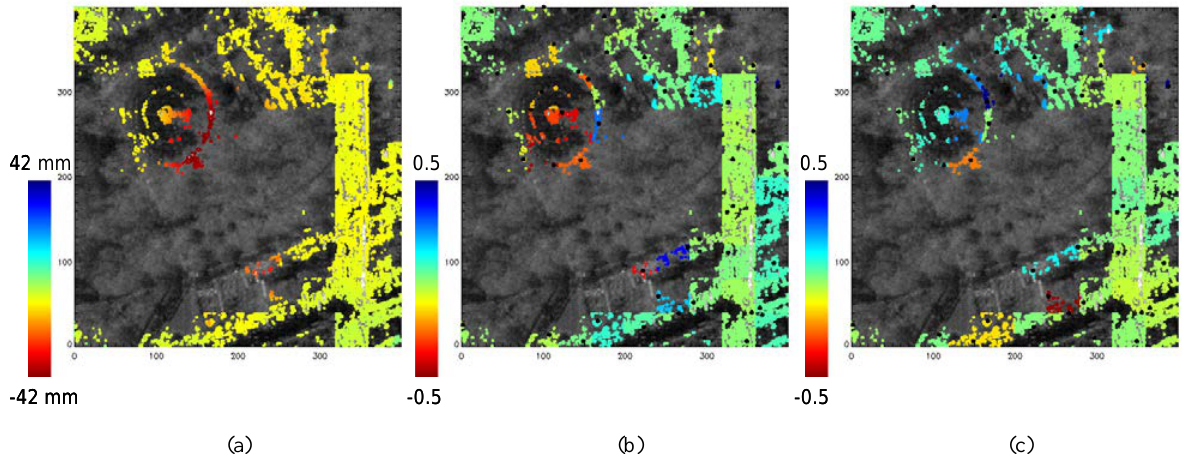
Figure 4: Deformation estimation results using a different approach (adaptive spatial phase filtering and L1 based SBAS technique). (a) The total deformation in mm. (b) Local tilts of deformation velocity in range (x) direction in mm/year/pixel calculated from (a). (c) Local tilts of deformation velocity in azimuth (y) direction in mm/year/pixel calculated from